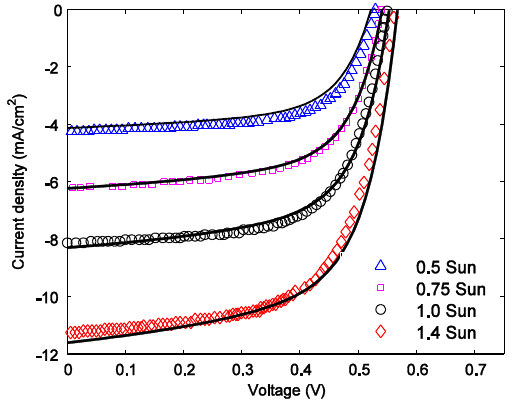
Figure 5. Current-voltage characteristics of a P3HT:PCBM solar cell at different sun intensities. The symbols represent experimental data and solid lines represent the model fit to the experimental data.